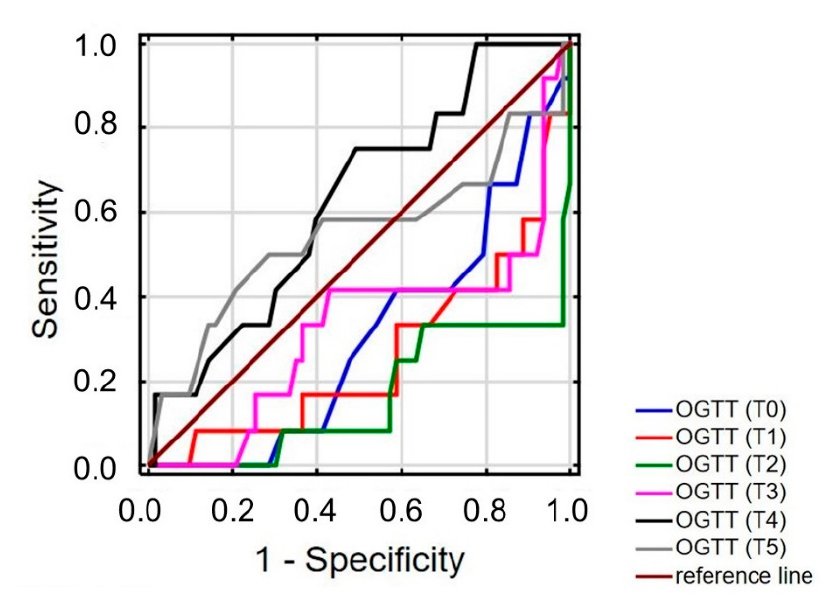
Figure 4. ROC graph for patients with reactive hypoglycemia. OGTT—Oral Glucose Tolerance Test; T0—measurement taken in fasting state; T1—first hour of measurement, T2—second hour of measurement; T3—third hour of measurement; T4—fourth hour of measurement; T5—fifth hour of measurement.